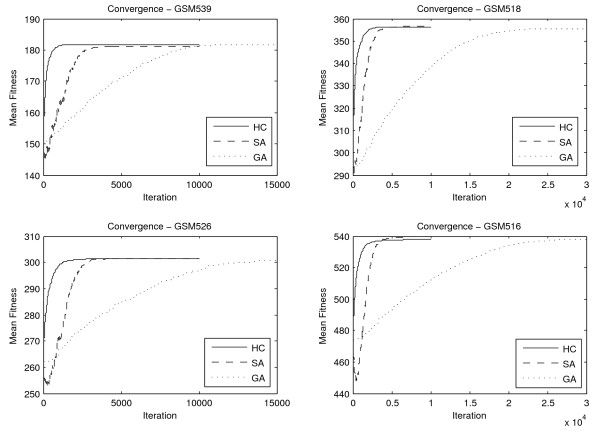
Convergence per method for a subset of 4 microarray experiments. The solid line corresponds to the mean hill climbing fitness reached at each iteration, the dashed line to the simulated annealing and the dotted line to the genetic algorithm. Experiments were chosen to roughly cover the range of fitness values reached in all microarray experiments. Experiments GSM539 and GSM516 where the ones with the least and most possible allocation positions and thus the ones producing the smallest and largest fitness values in the dataset respectively. Fitness values for experiments GSM518 and GSM526 are equally distanced from the two extremes.